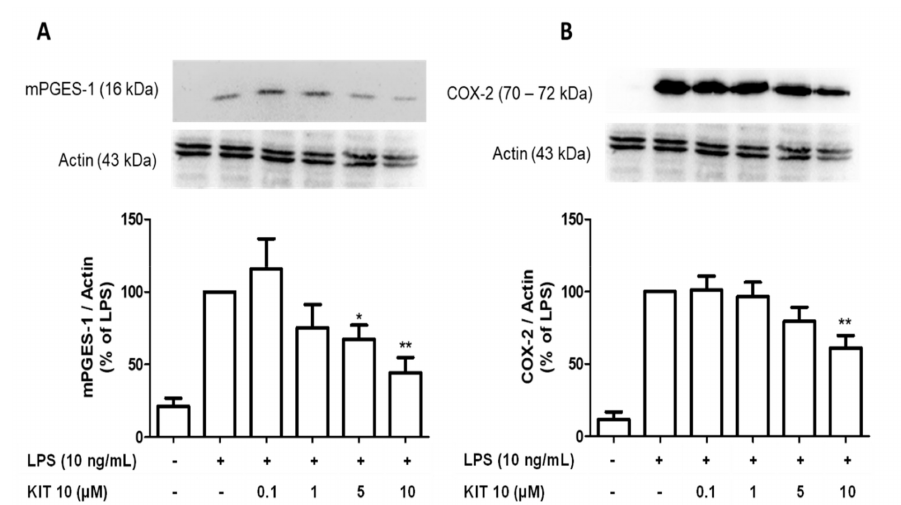
Figure 3. KIT 10 reduced LPS-induced COX-2 and mPGES-1 protein levels in primary rat microglia. Cells were pre-treated with different concentrations of KIT 10 for 30 min before stimulation with LPS. After 24 h, western blot analysis was performed to determine protein levels of mPGES-1 ( A ) and COX-2 ( B ) in cells. Representative original blots are included in Appendix A (Figure A1). Protein levels were normalized to β -actin loading control (n = 5–6). * p < 0.05, and ** p < 0.01with respect to LPS (One-way ANOVA followed by the Newman-Keuls